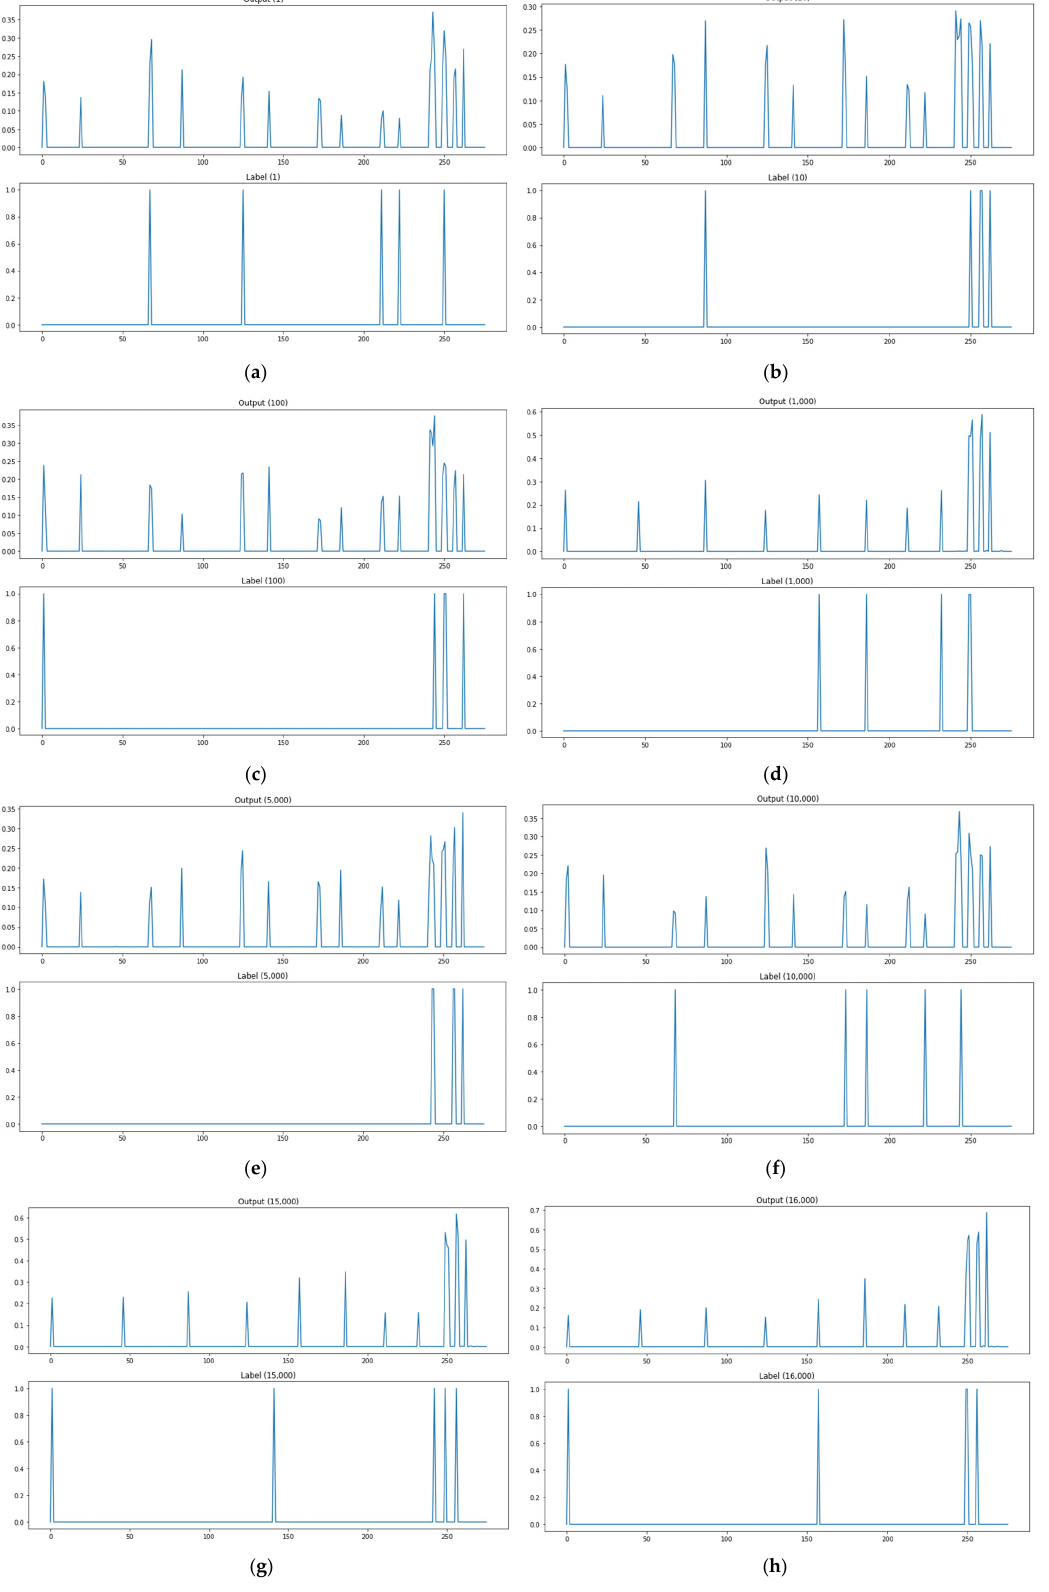
Figure 12. The outputs of the ANN and deep learning—output layer with sigmoid (model 1). ( a ) Test data 1. ( b ) Test data 10. ( c ) Path test data 100. ( d ) Path test data 1000. ( e ) Path test data 5000. ( f ) Path test data 10,000. ( g ) Path test data 15,000. ( h ) Path test data 16,000.